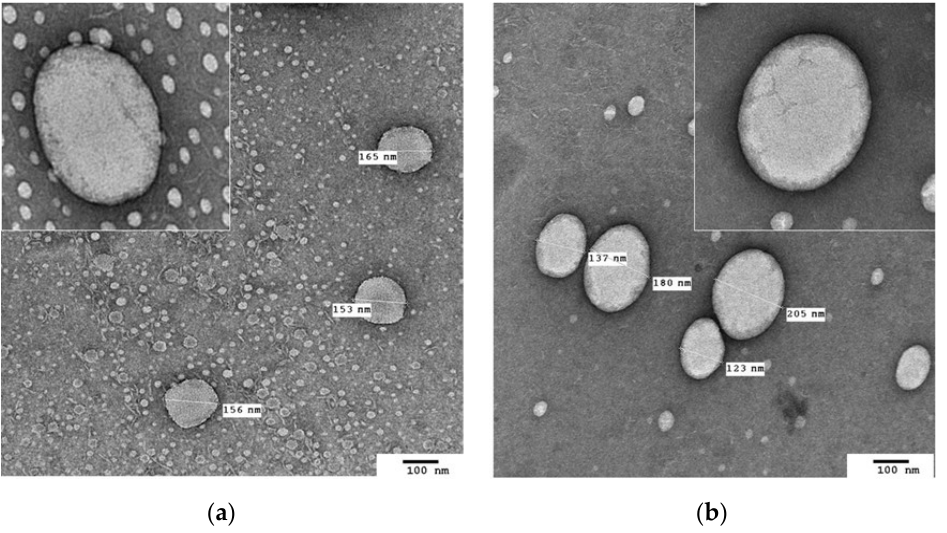
Figure 2. TEM micrographs of NLC-SF formulated with 2% of Span 80 as surfactants, sunflower oil, and myristic acid (C14:0) in ( a ) NLCs formulated with SL:LL = 60:40 (wt%), ( b ) NLCs formulated with SL:LL = 40:60 (wt%) .